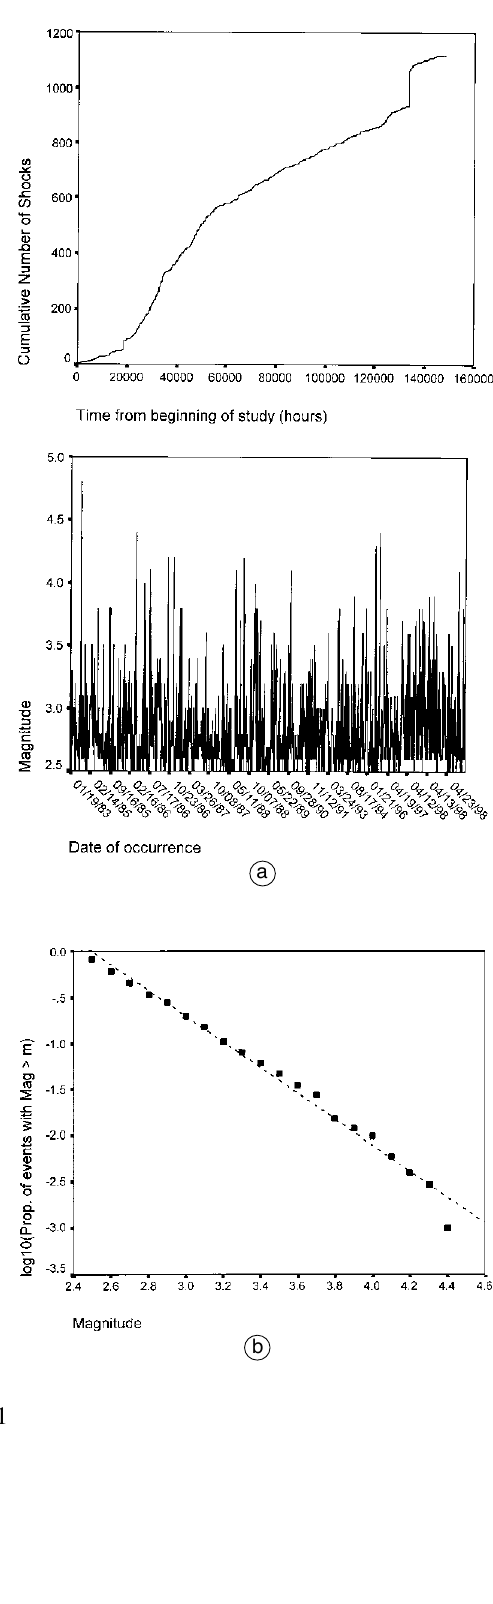
Fig. 2a,b. Basic descriptive plots of the seismic data: a) cumulative number of shocks and plot of the magnitudes versus the occurrence times; b) cumulative distribution of